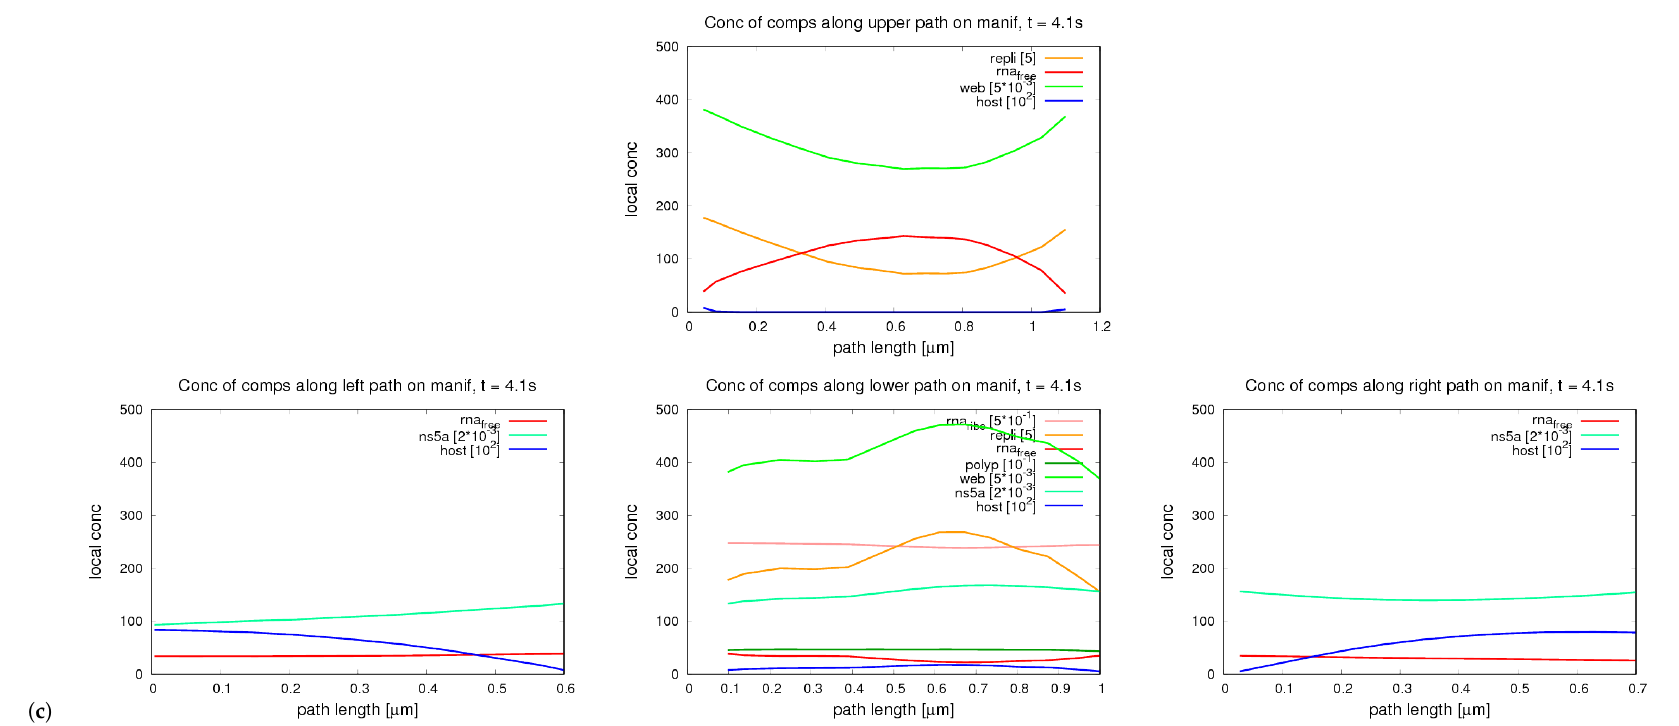
Figure 8. 1D profiles of concentrations along the short path (as shown in Figure 3) around a single web. (For details, cf. Section 3.5.) One sees clearly how the concentrations are strongly enhanced around and especially within the web: first time point of observation ( a ): t = 2.8 s; second time point of observation ( b ): t = 3.5 s; and third time point of observation ( c ): t = 4.1 s. Note: Ordering of the figures corresponds to the spatial order of the sub paths as displayed in Figure 4. (Each single sub graphics of each sub figure corresponds to one sub path, i.e., the time evolution of the concentrations of each sub path is reflected by means of the values shown in the corresponding sub graphics of each sub figure. The ordering of the single graphics belonging to a certain time point of evaluation corresponds to the sub paths which are depicted in Figure 4. To this end, for example, the left sub graphics of sub figure ( a ),( b ) and ( c ) belongs to the left sub path at the time points t = 2.8 s, t = 3.5 s, and t = 4.1 s.) Note that the concentrations belong to one single web and its close environment in this case, since the geometrical space observed refers to a single web and its close environment. The peaks of concentration are hence related to special locations inside the web under consideration. (Results of grid refinement level